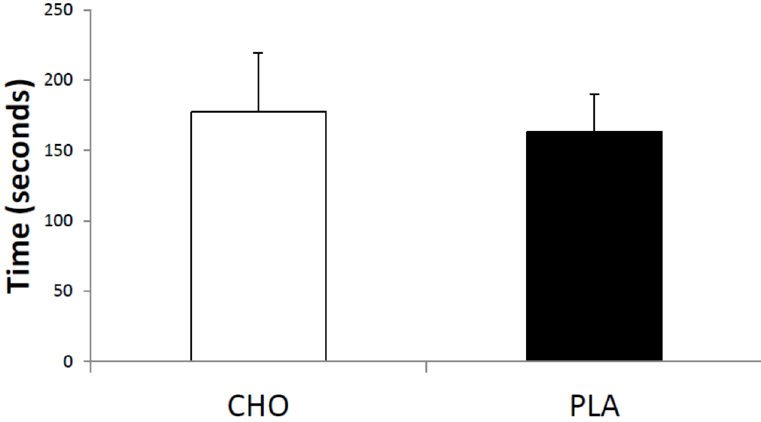
Figure 1. Time (seconds) to exhaustion during high ‐ intensity exercise. CHO = carbohydrate; and PLA = placebo.